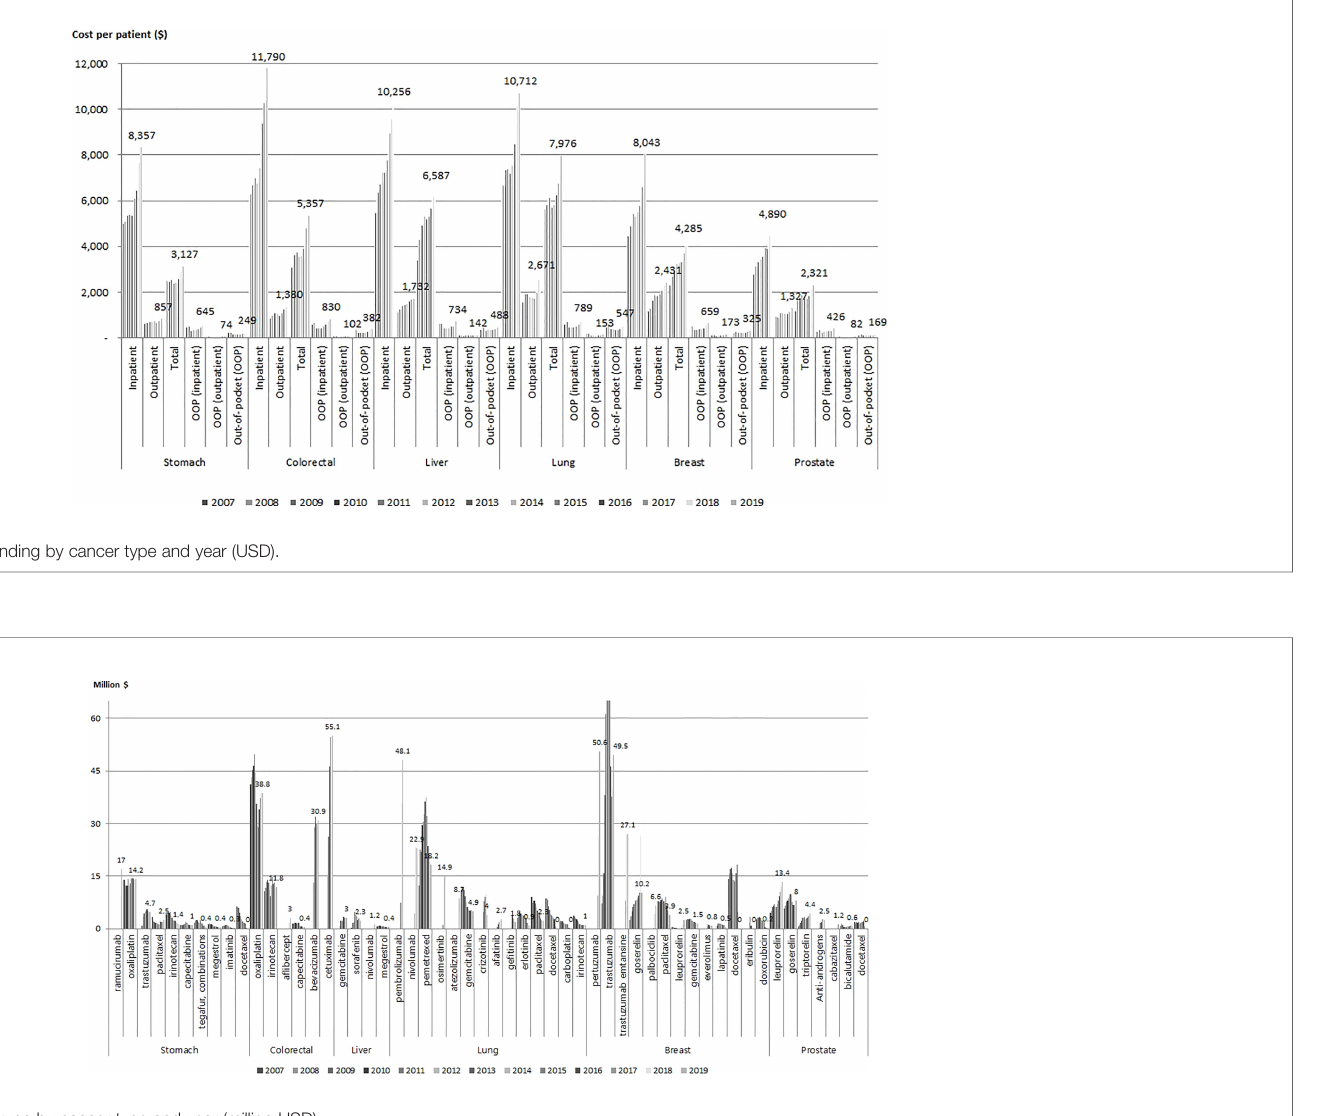
FIGURE 2 | Market share of anti-cancer drugs by cancer type and year (million